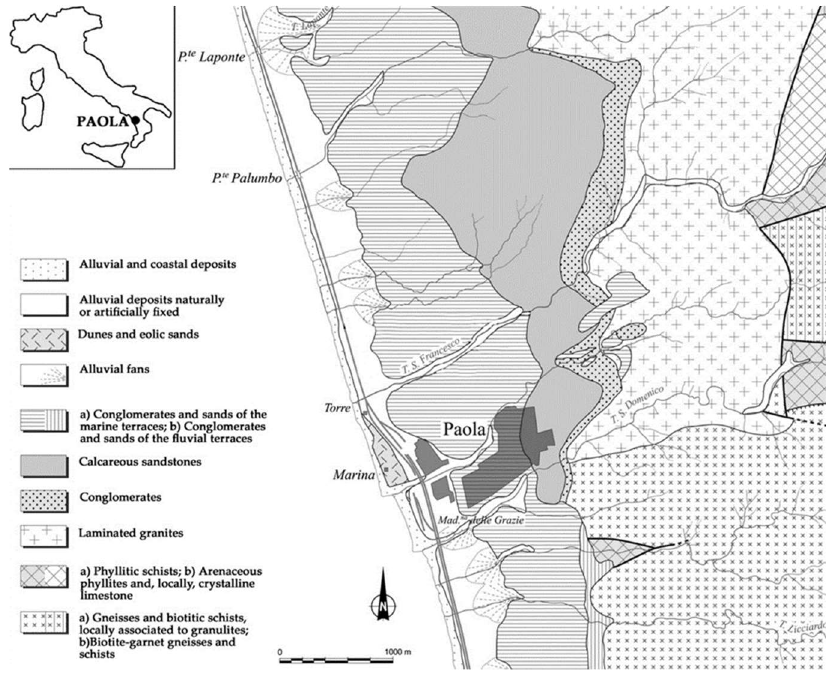
Figure 2. The geological map of the area around Paola, Calabria region, southern Italy.